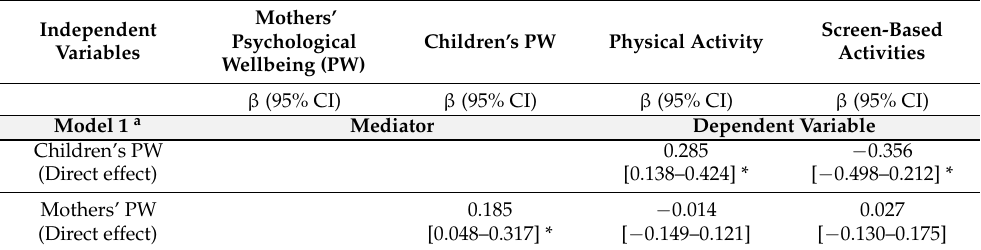
Table 2. Direct and indirect effects of financial wellbeing on children health behaviors via mothers’ and children’s psychological